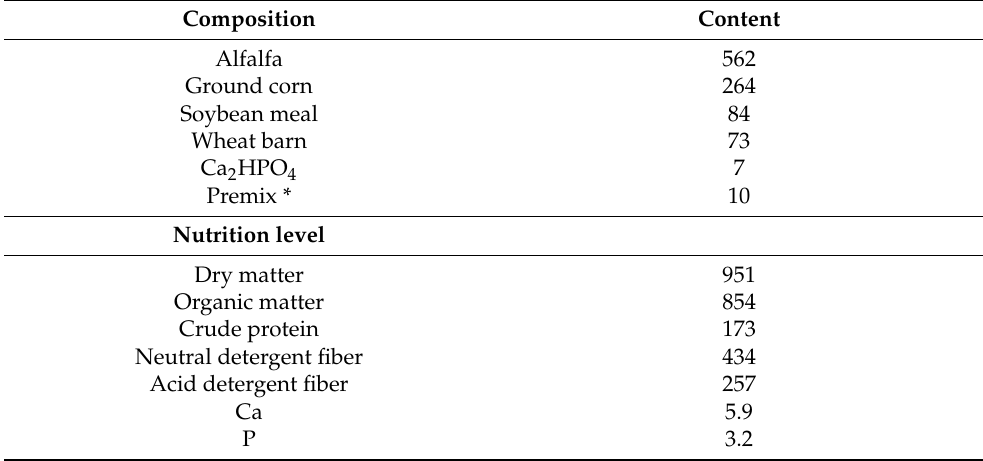
Table 1. The composition and nutrition level of the basic diet fed to the goats